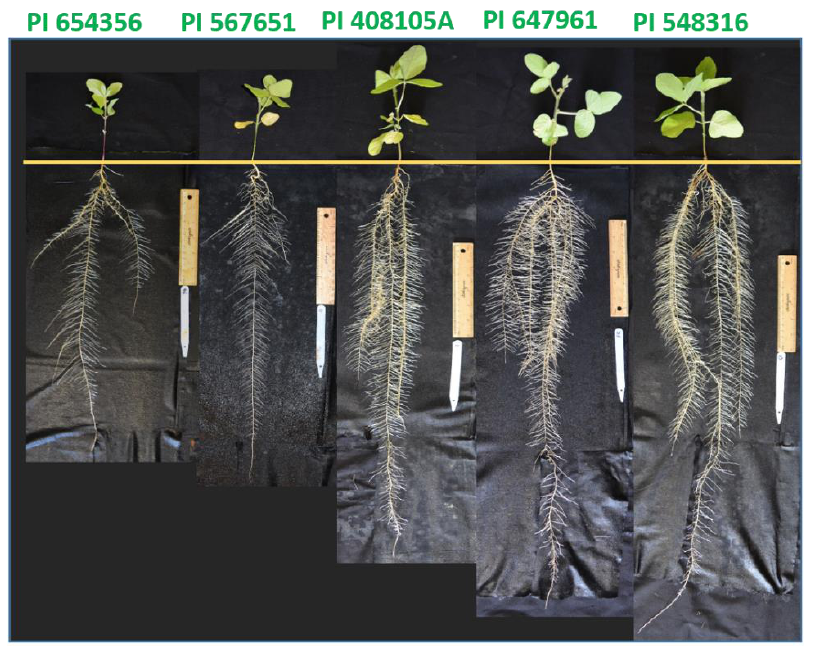
Figure 2. Example of soybean genotypes with contrasting root systems grown in a semi-hydroponic phenotyping platform in a temperature-controlled glasshouse harvested 35 days after sowing.